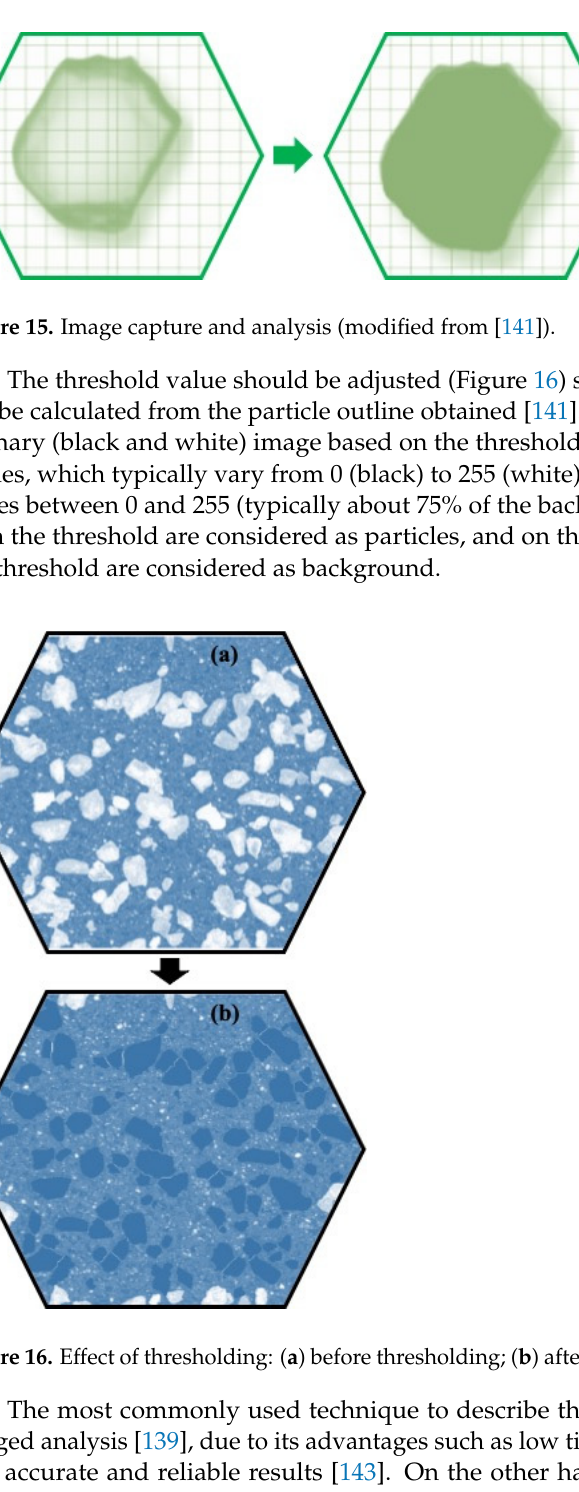
Figure 14. The typical algorithm used for image analysis (modified from [140]).